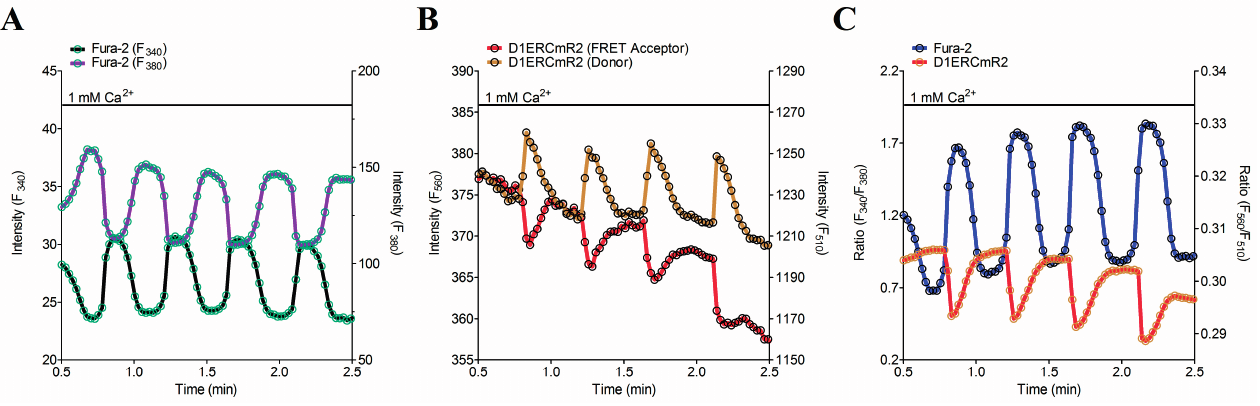
Figure 6. Time course of [Ca 2+ ] Cyto and [Ca 2+ ] ER in a single HEK E2 cell visualizing oscillatory traces in 1 mM Ca 2+ . ( A ) Single emission curves of fura-2 either excited at 340 nm (black curve) or 380 nm (blue curve); ( B ) Donor and FRET acceptor fluorescences of D1ERCmR2 at 560 nm (red curve) or 510 nm (green curve), respectively; ( C ) Overlay of ratio curves from fura-2 (blue curve) or D1ERCmR2 (red